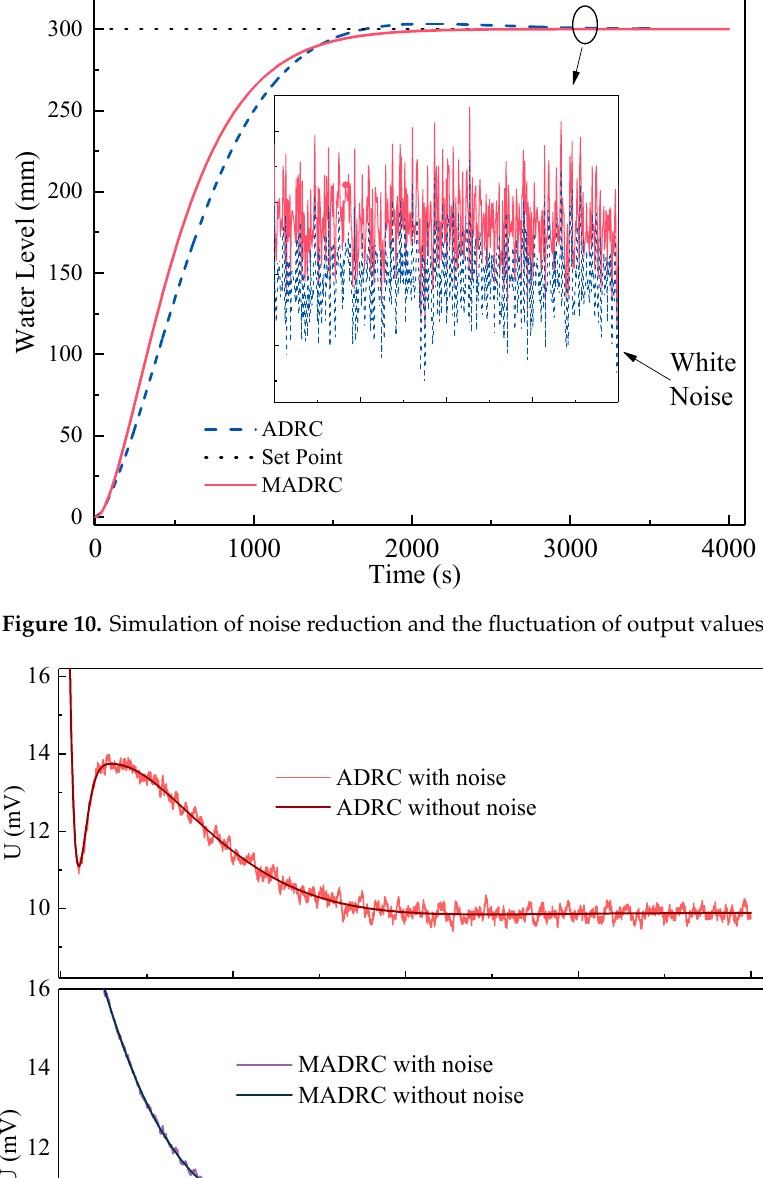
Figure 11. The fluctuations of control variables of the two ADRC.